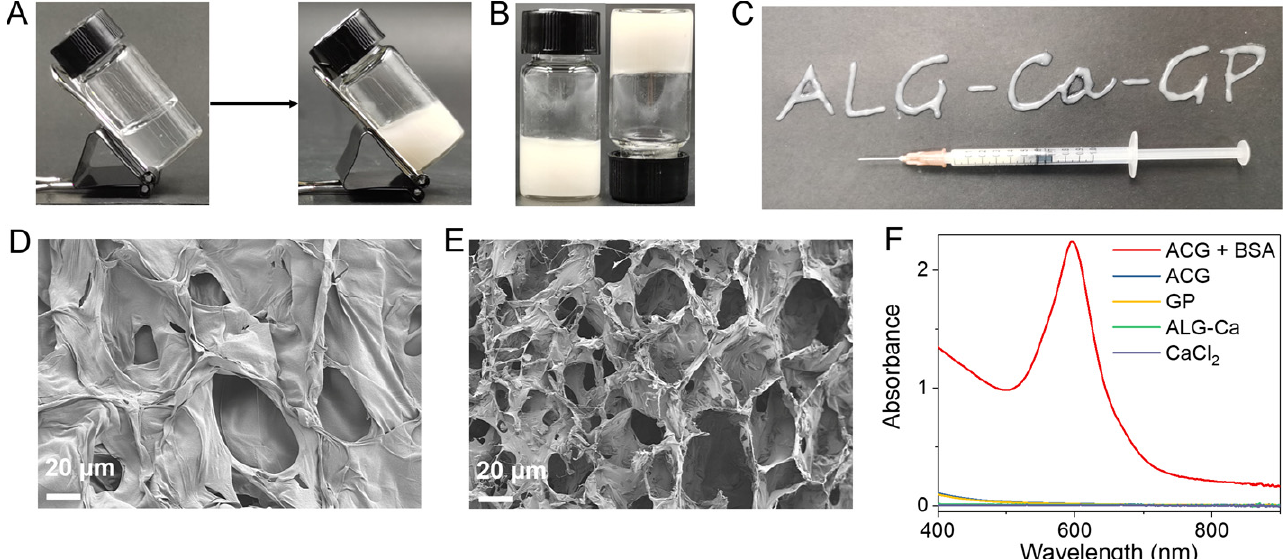
Figure 1. Characterization of the ACG hydrogel. ( A ) The tilted ALG–Ca hydrogel (left) and ACG hydrogel (right). ( B ) The photograph of ACG hydrogel (upright and inverted). ( C ) The pattern of “ALG–Ca–GP” is coherently formed by the ACG hydrogel with a 1 mL syringe. SEM image of ALG– Ca hydrogel ( D ) and ACG hydrogel ( E ), Scale bar: 20 μ m. ( F ) UV–vis–NIR absorption spectra of ACG + BSA (10 mg/mL) hydrogel, ACG hydrogel, ALG–Ca hydrogel, GP and CaCl 2 after fourfold dilution.